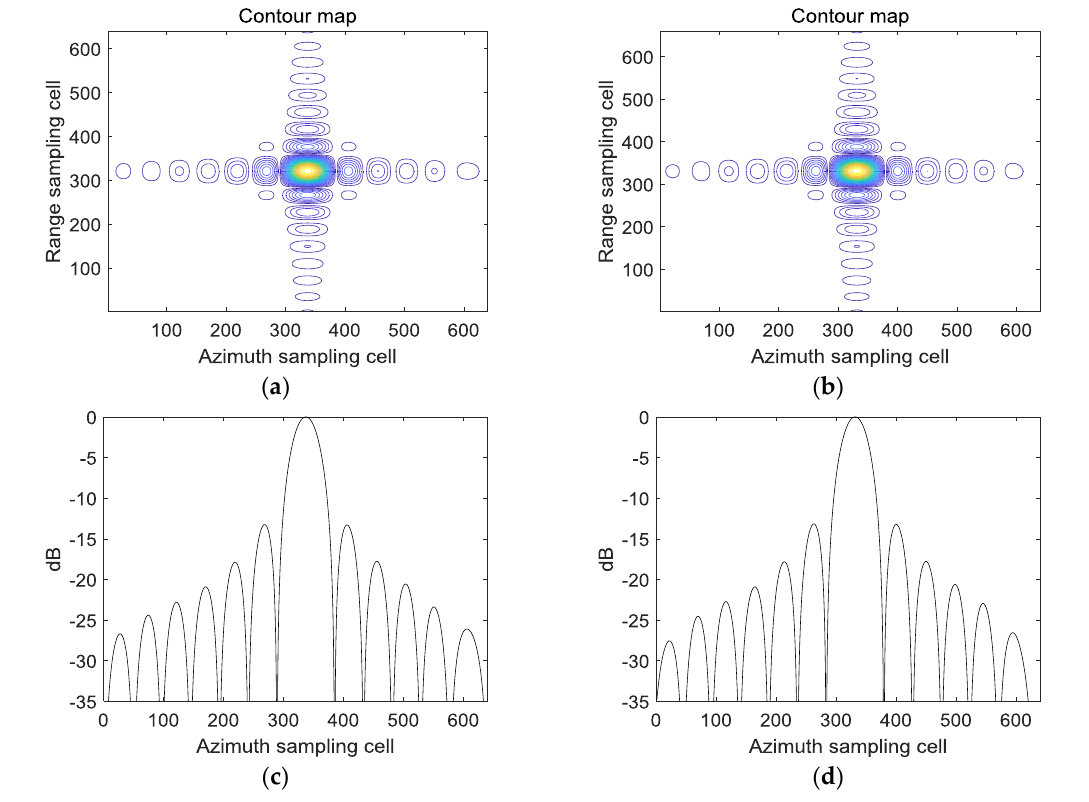
Figure 9. Results of the standard full-aperture CSA and the proposed method: ( a ) standard CSA; ( b ) proposed method; ( c ) azimuth profiles based on the standard CSA; ( d ) azimuth profiles based on the proposed method.